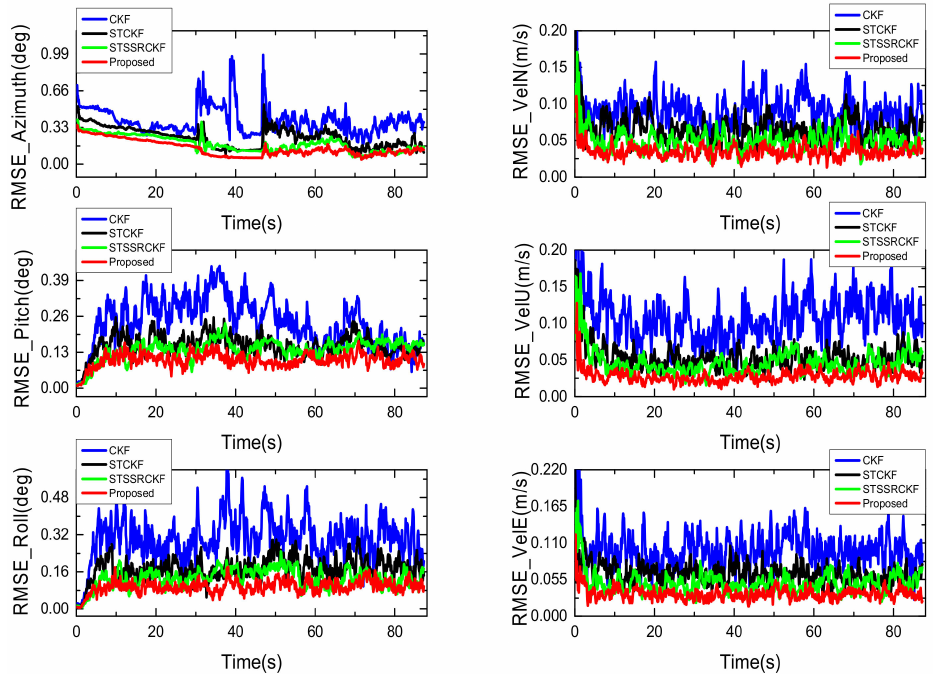
Figure 2. RMSEs of the attitude ( left ) and velocity ( right ).